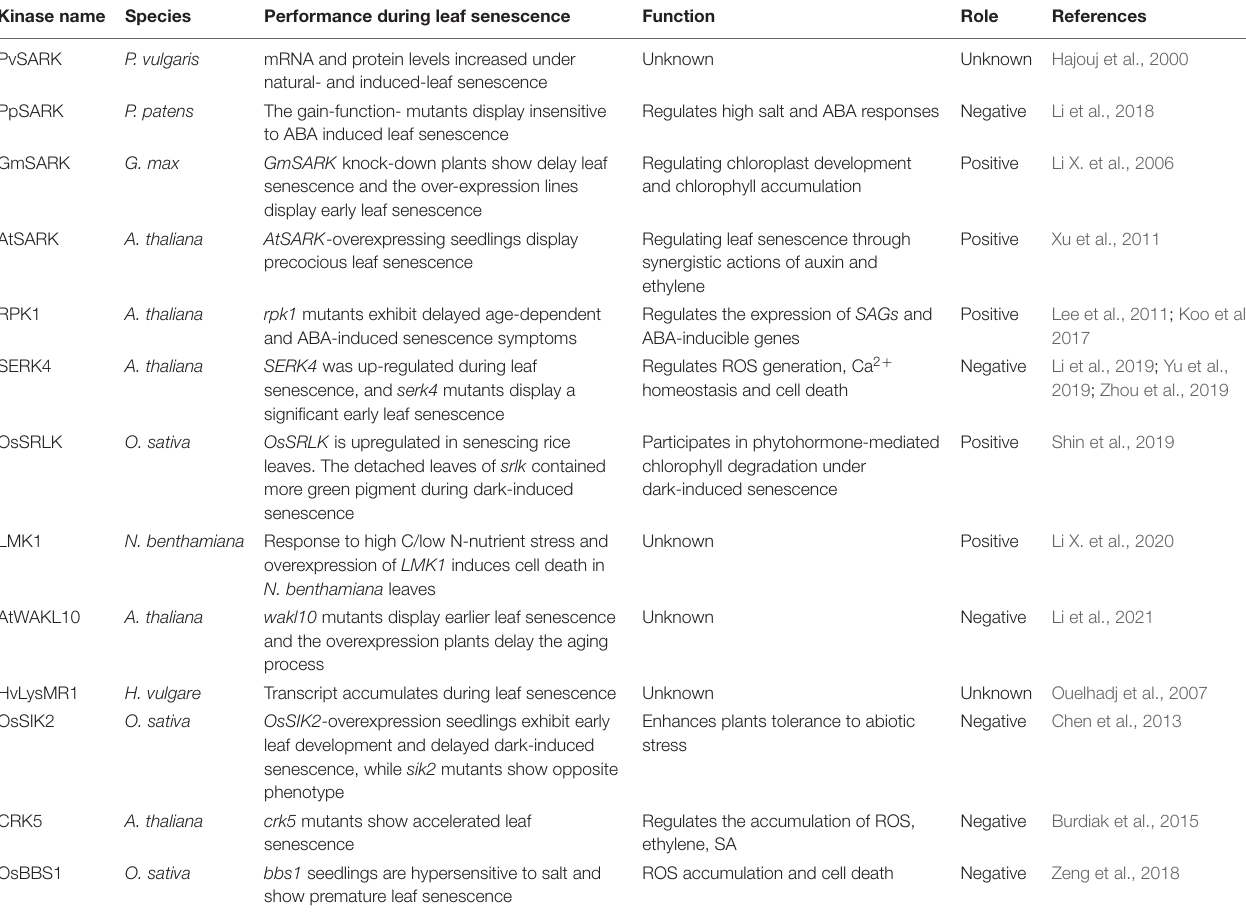
TABLE 1 | Receptor-like kinases (RLKs) function in the regulation of leaf